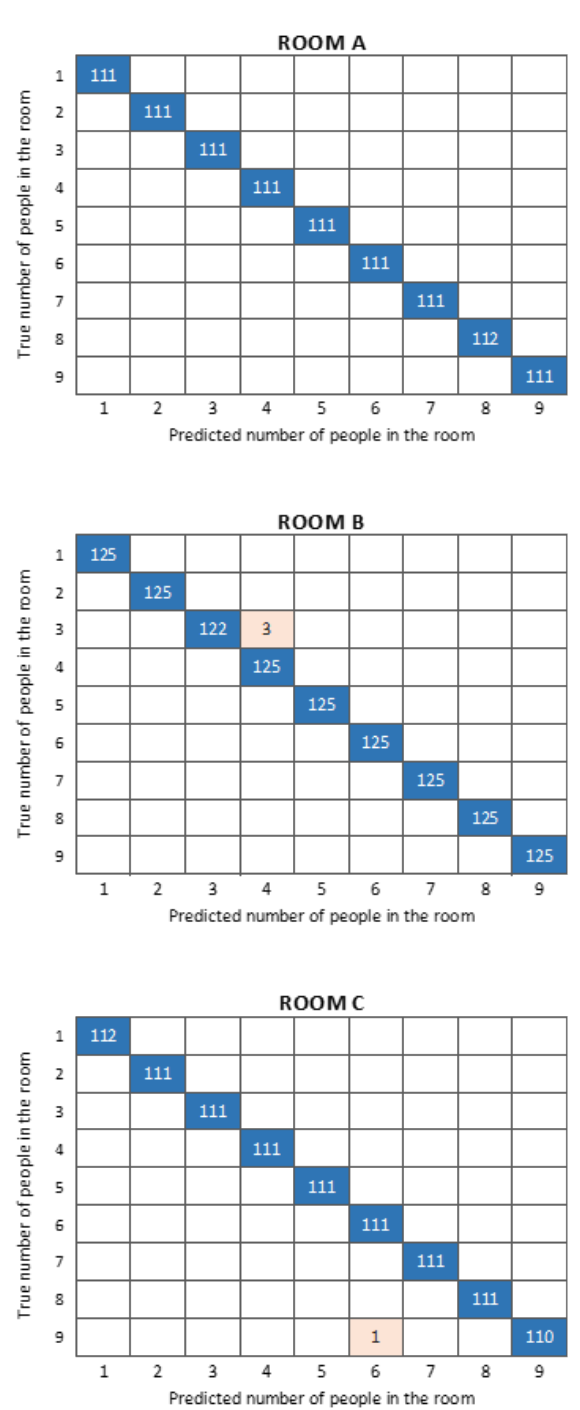
Figure 7. Confusion matrices for SVM-Gaussian with multi-link SD descriptors in all